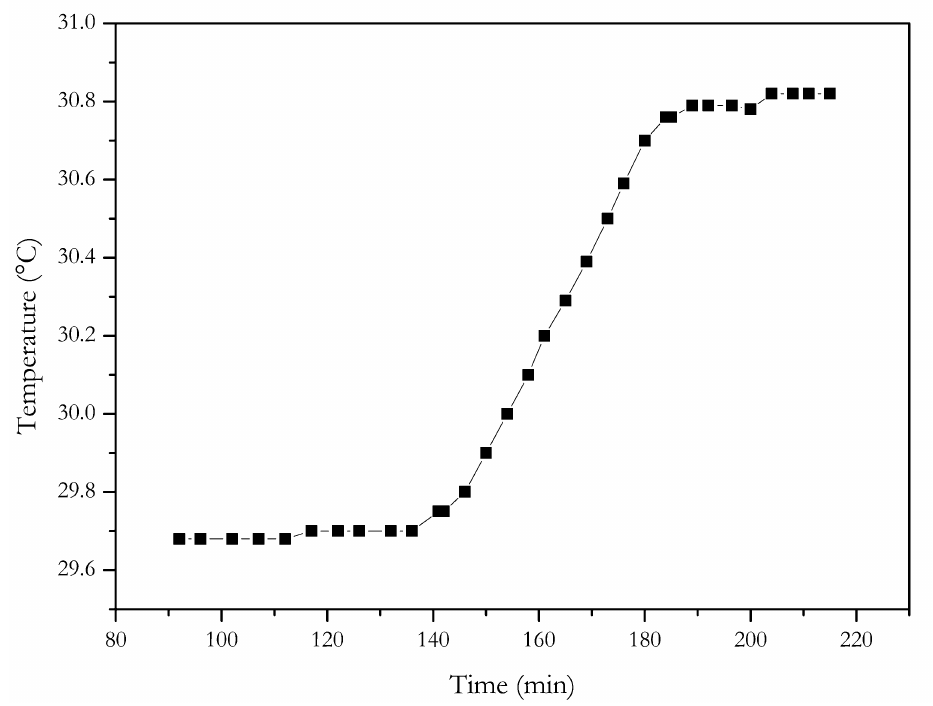
Figure 9. Temperature increase of the inside the